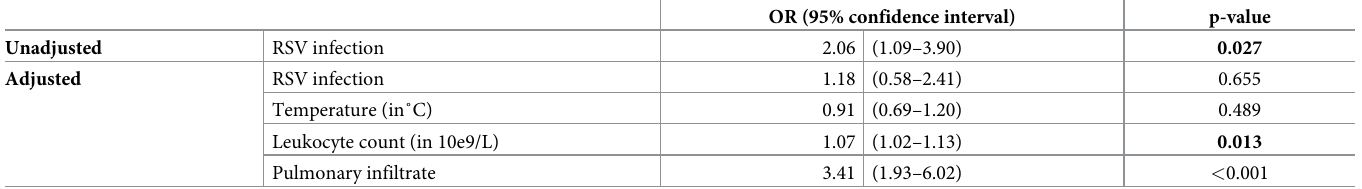
Table 3. Univariate and multivariable analysis for the probability of ICU admission or death within 7 days after hospital admission in patients with RSV compared to influenza virus infection.